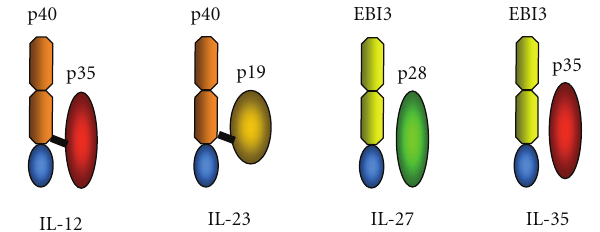
Figure 1: Schematic representation of structure of members of the IL-12